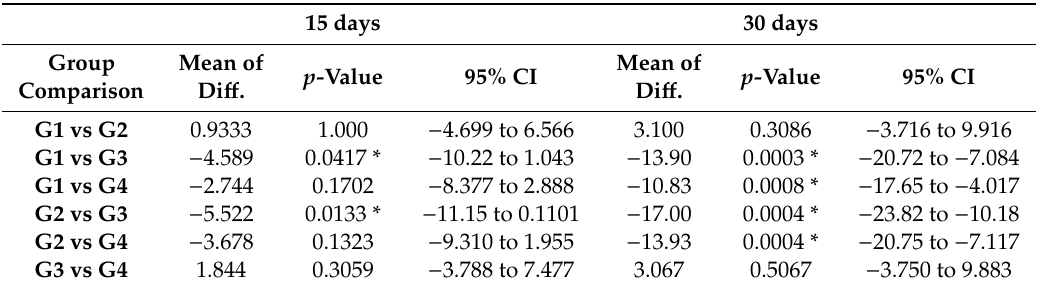
Table 5. Table data (mean and standard deviation) of bone-to-implant contact percentage (BIC%) measured around the surface of each sample.